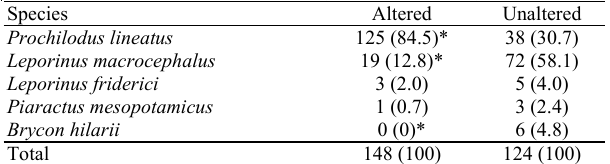
Table 1. Frequency of species acting as nuclear in the altered and unaltered sites, córrego Olho d’Água, Central-West Brazil. Numbers in parenthesis indicate percentage. *indicates p < 0.05 in between areas comparison.